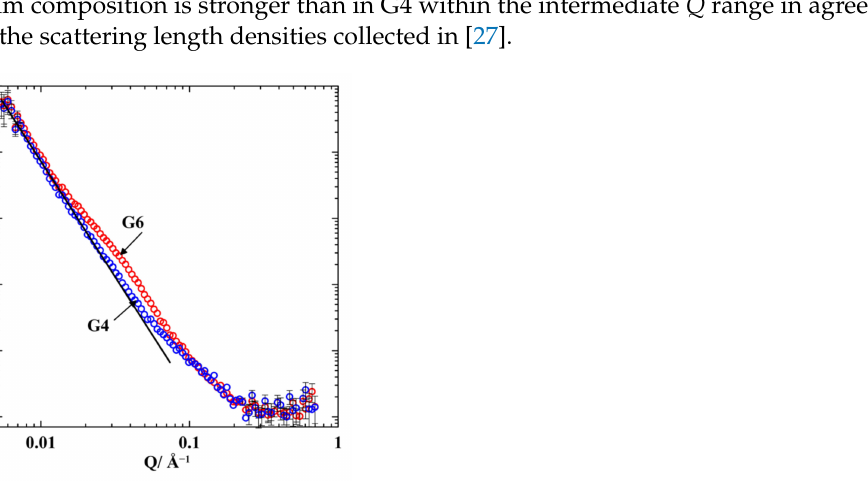
Figure 3. Normalized SANS intensities for G4 (empty symbols) and G6 (filled symbols). The straight line shows the I ~ Q − 3.5